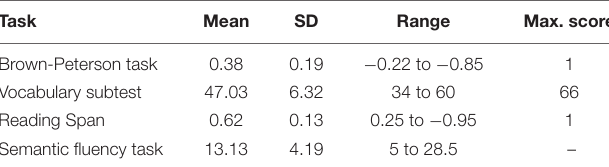
FIGURE 1 | Mean number of words recalled per list in the Brown-Peterson task. TABLE 1 | Descriptive statistics for the supplementary tasks.